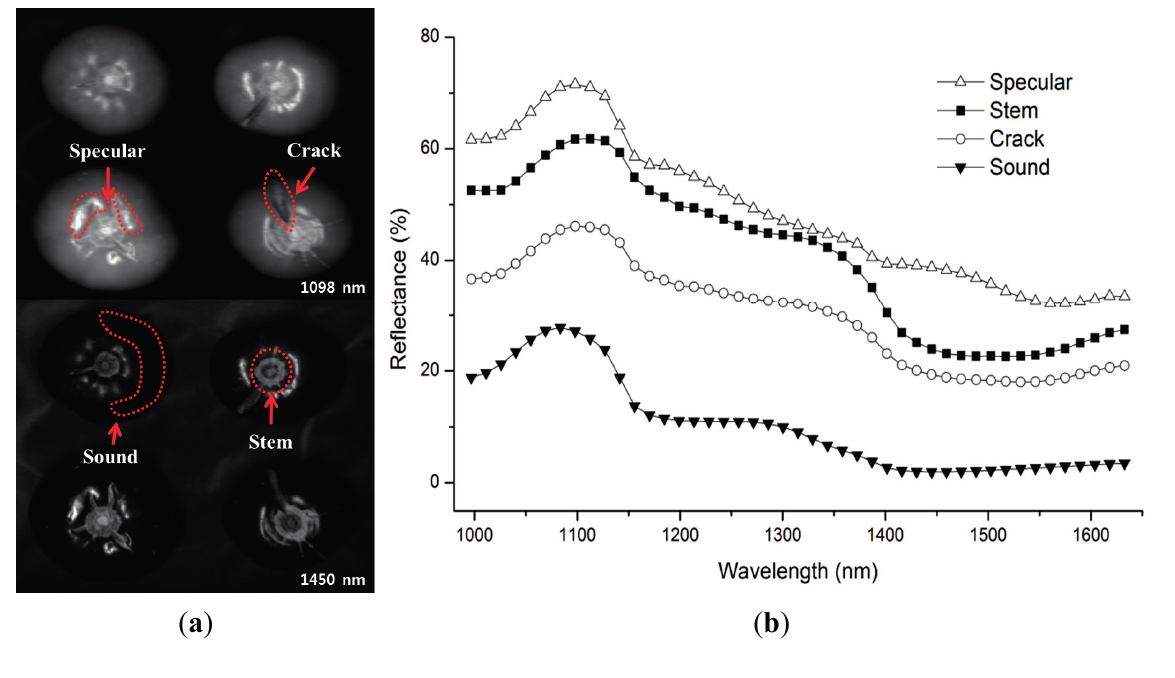
Figure 3. Representative reflectance images at 1098 nm and 1450 nm of tomatoes with cracks ( a ). Mean reflectance spectra of specular, stem-scar, cracks, and sound regions obtained from the hyperspectral NIR image data ( b